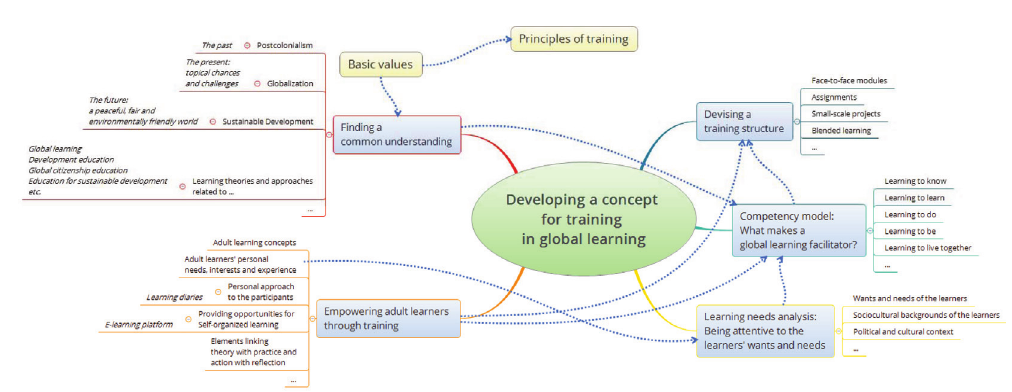
Figure 1: Elements for designing training for global learning facilitators, as developed in the context of the Facilitating Global Learning